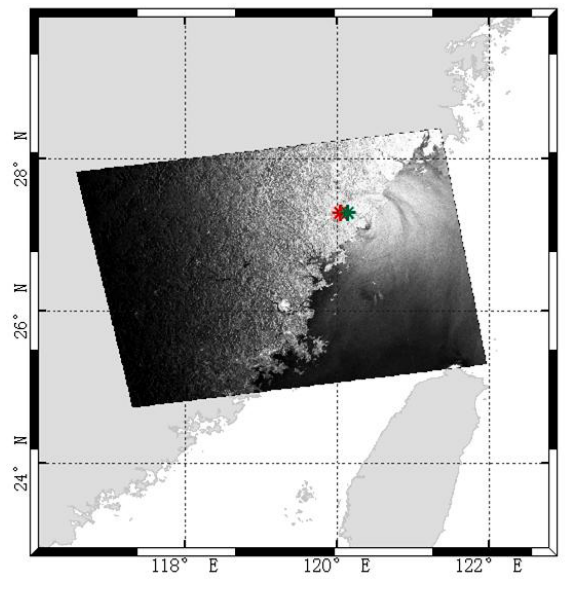
Figure 1. Radarsat synthetic aperture radar (SAR) Image of Typhoon Saomai landed along the east coast of China on 10 August 2006 at 10:02 UTC with eye over the coastline, and the typhoon eye centers estimated from a multifunctional transport satellite (MTSAT) (red dot) and FY-2 (green dot) infrared (IR)